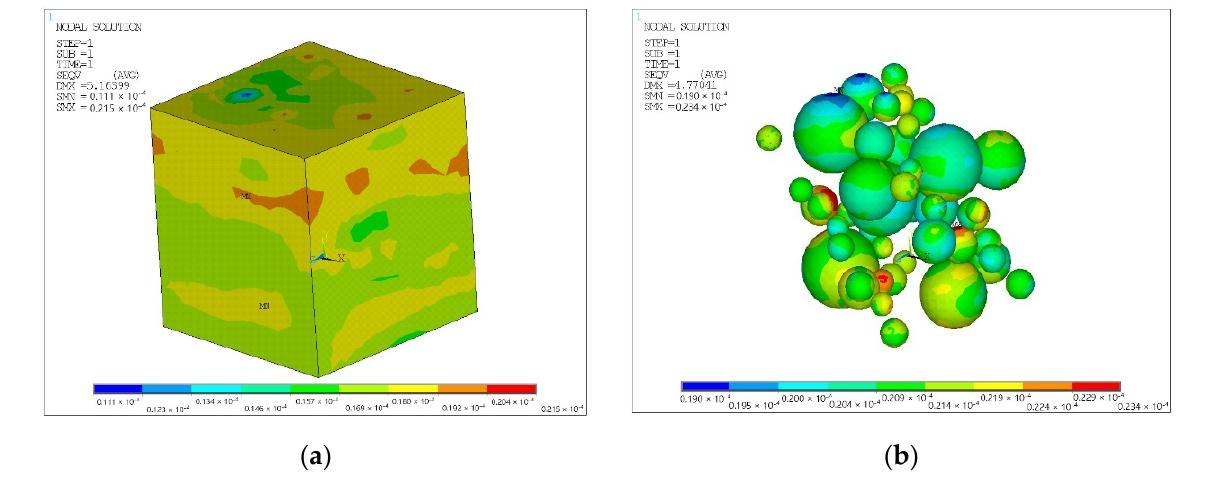
Figure 5. Equivalent von Mises stress for matrix ( a ) with spherical filler ( b ), (10 − 6 MPa).